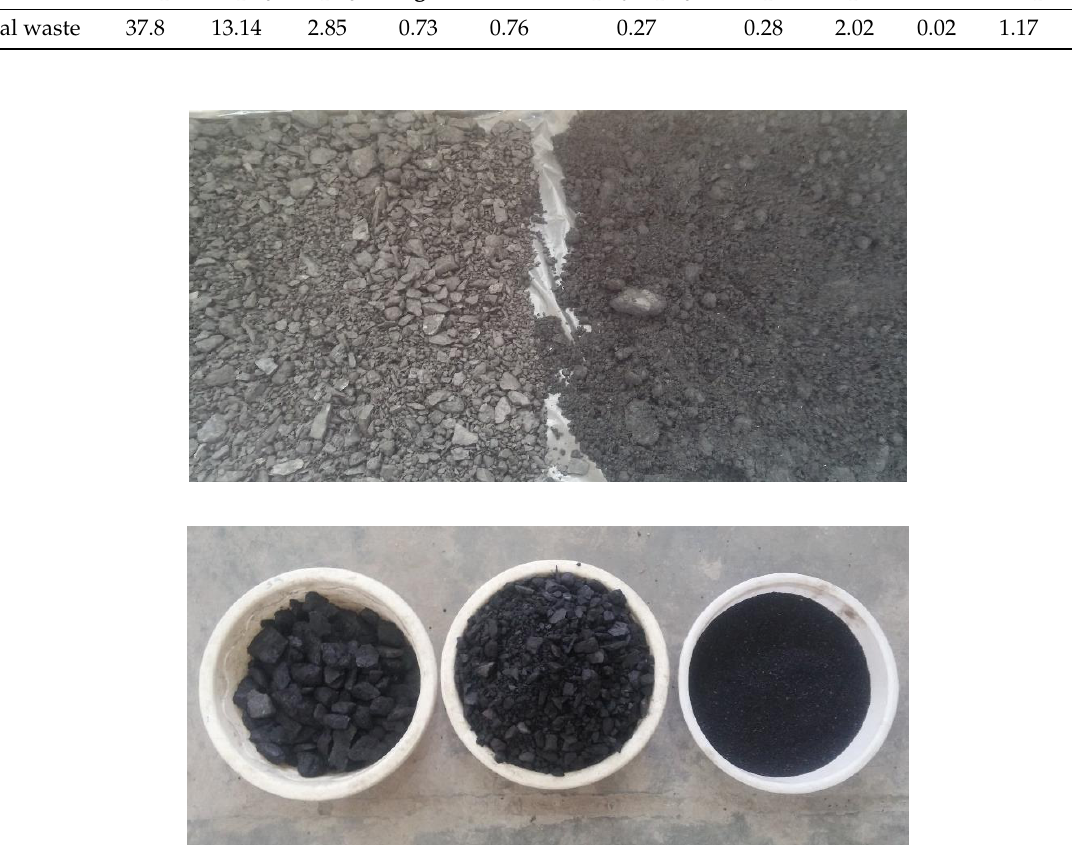
Figure 2. Untreated coal waste .